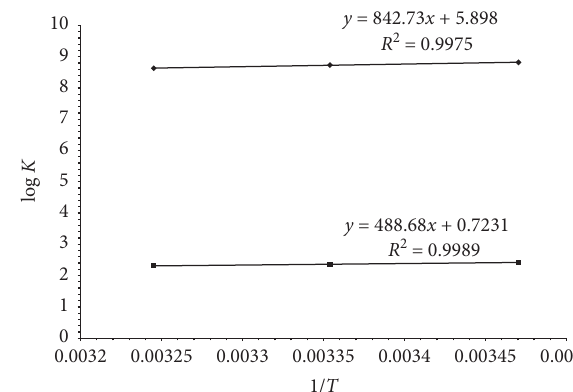
Table 9: Thermodynamic parameters for Zn(II) and Cd(II) complexes in 50% DMSO-H